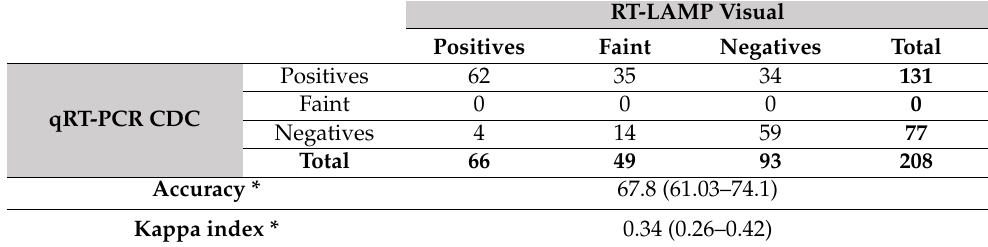
Table 3. Estimated performance of visual